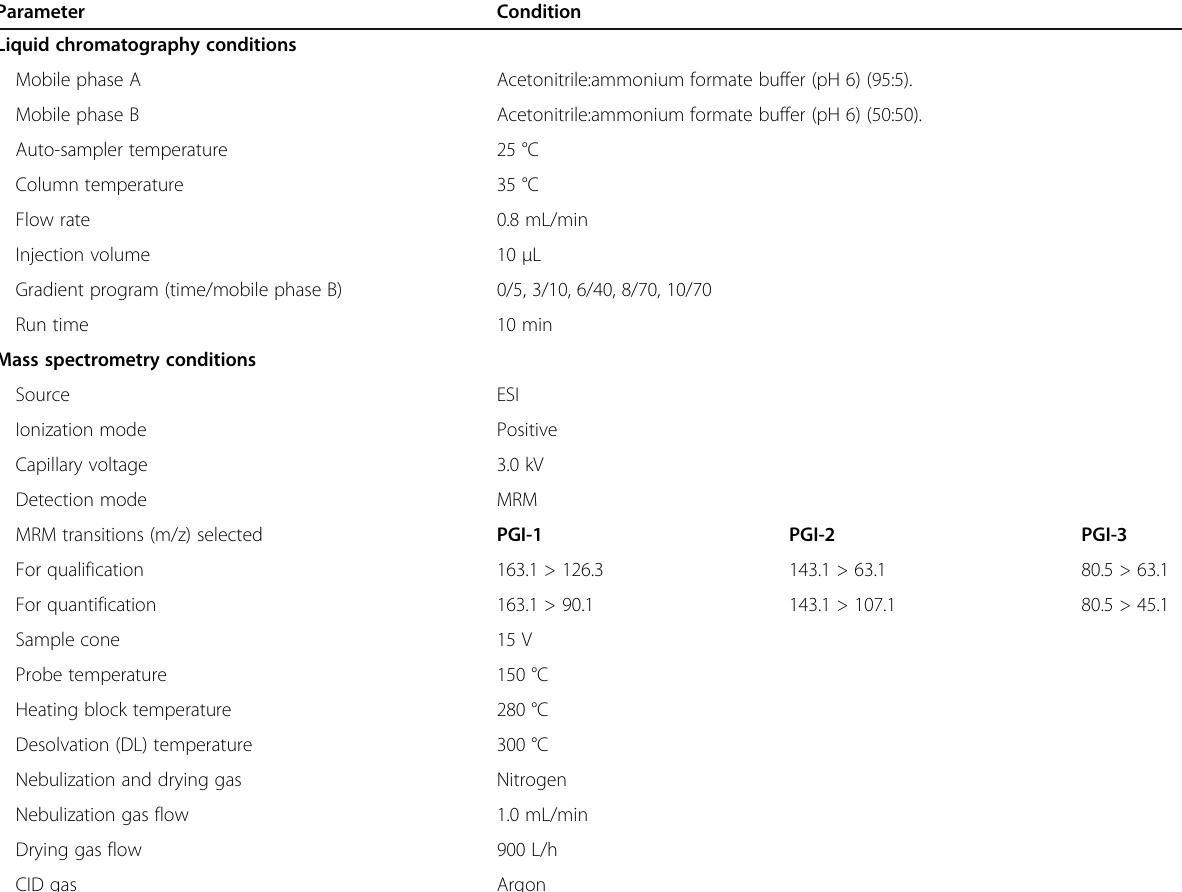
Table 1 Summary of optimized liquid chromatographic and mass spectrometric method